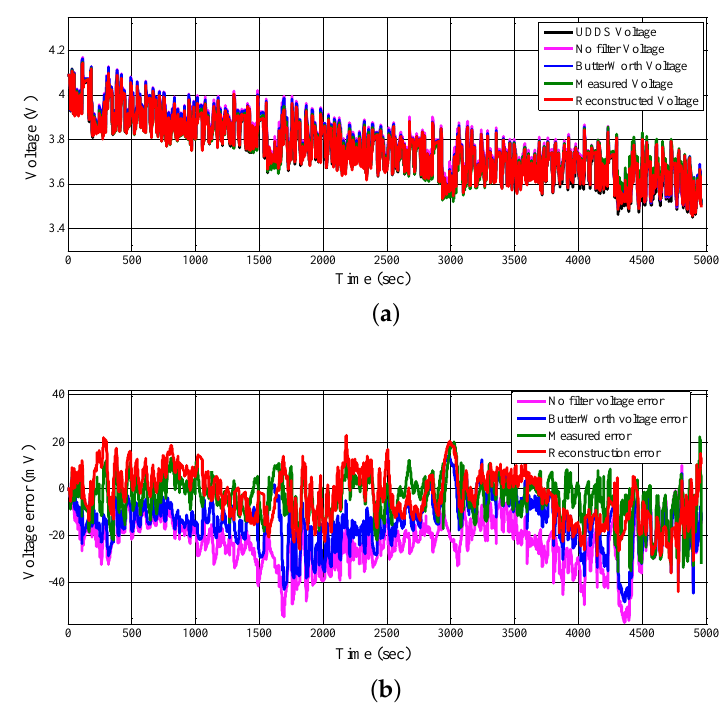
Figure 9. Simulated voltage results and errors under UDDS test at 25 ◦ C. ( a ) Comparison of the UDDS voltage and simulated voltages under UDDS test. ( b ) Simulated voltage errors with different methods under UDDS